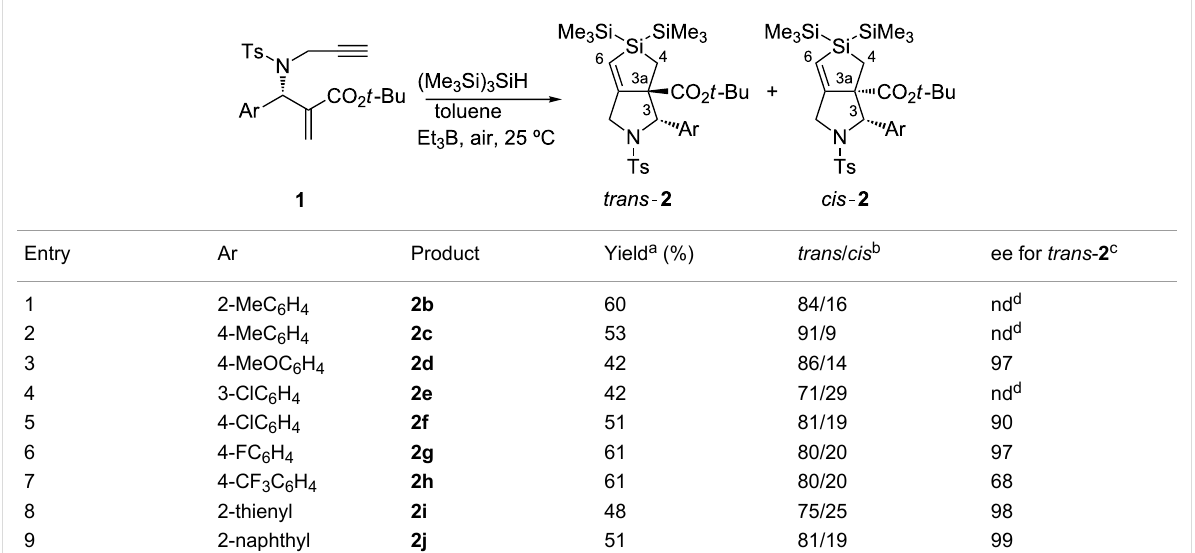
Table 2: Preparation of pyrrolidinodihydrosiloles 2 .